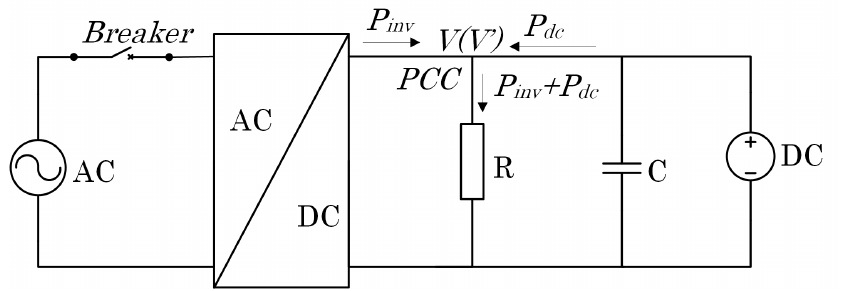
Figure 3. DC grid in normal and islanding